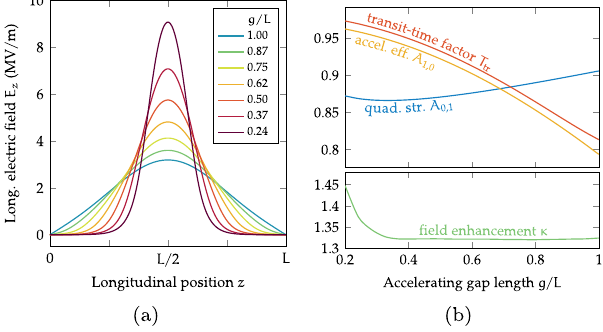
FIG. 8. Electric field E along the beam axis ( r ¼ 0 ) of a z trapezoidal cell with decreasing accelerating gap lengths g=L (a), as well as quadrupole term A 0 , acceleration efficiency A 1 ; 1 transit-time factor T as functions of g=L (b).